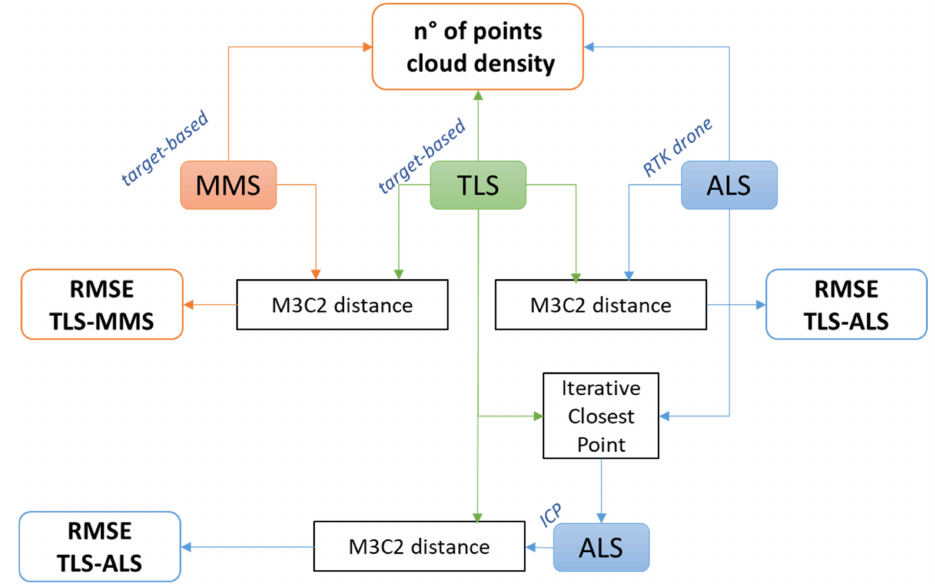
Figure 4. Validation analysis workflow to compare FARO Focus 3D X130 TLS, Kaarta Stencil 2–16 MMS, and DJI Zenmuse L1